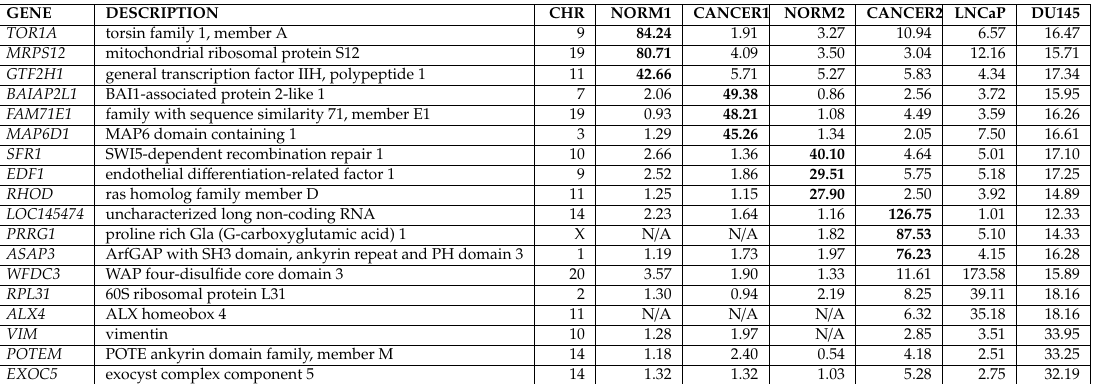
Table 3. Data from GSE133891 and GSE133906.